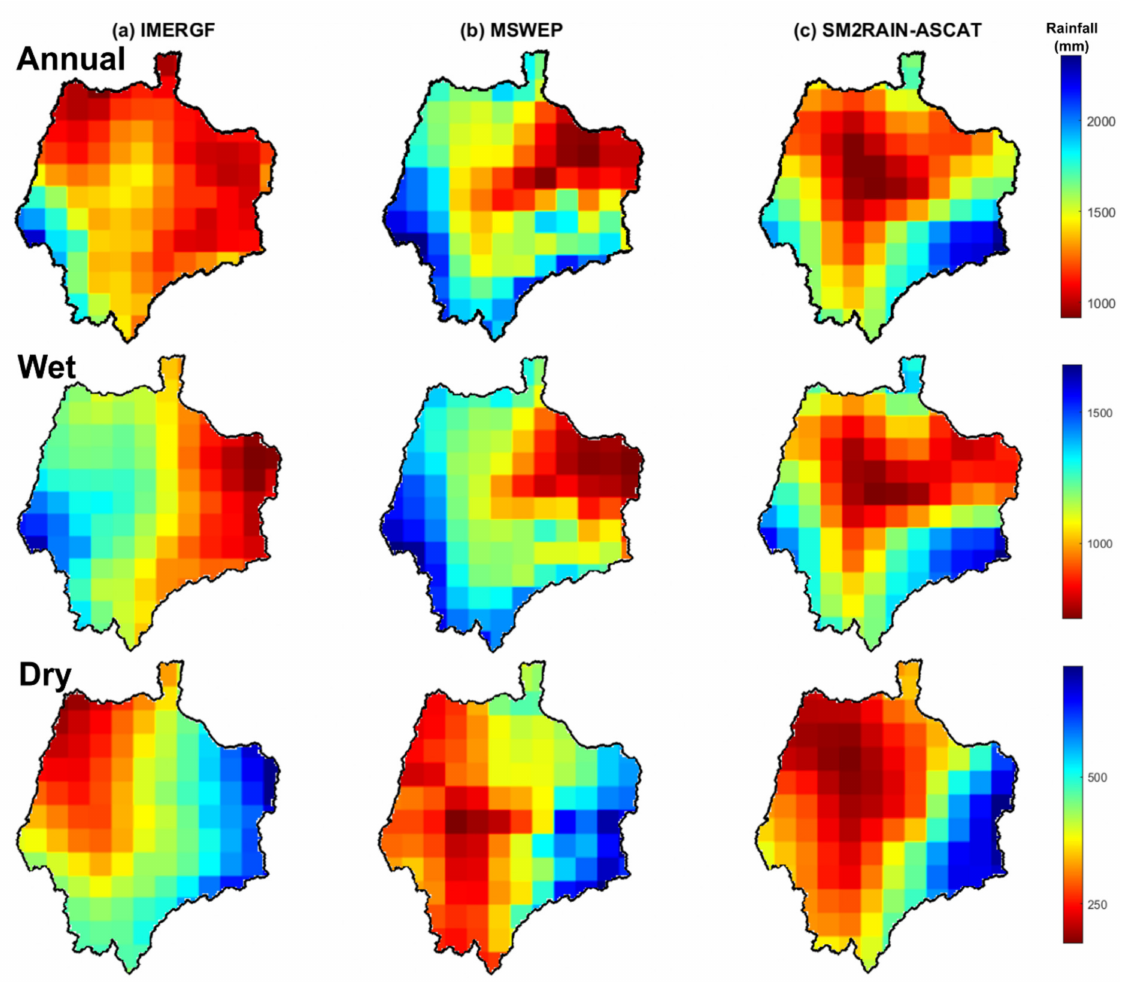
Figure 3. The accumulated precipitation for annual, wet, and dry seasons for ( a ) IMERGF-V6, ( b ) MSWEP, and ( c ) SM2RAIN–ASCAT. The color bar represents the rainfall